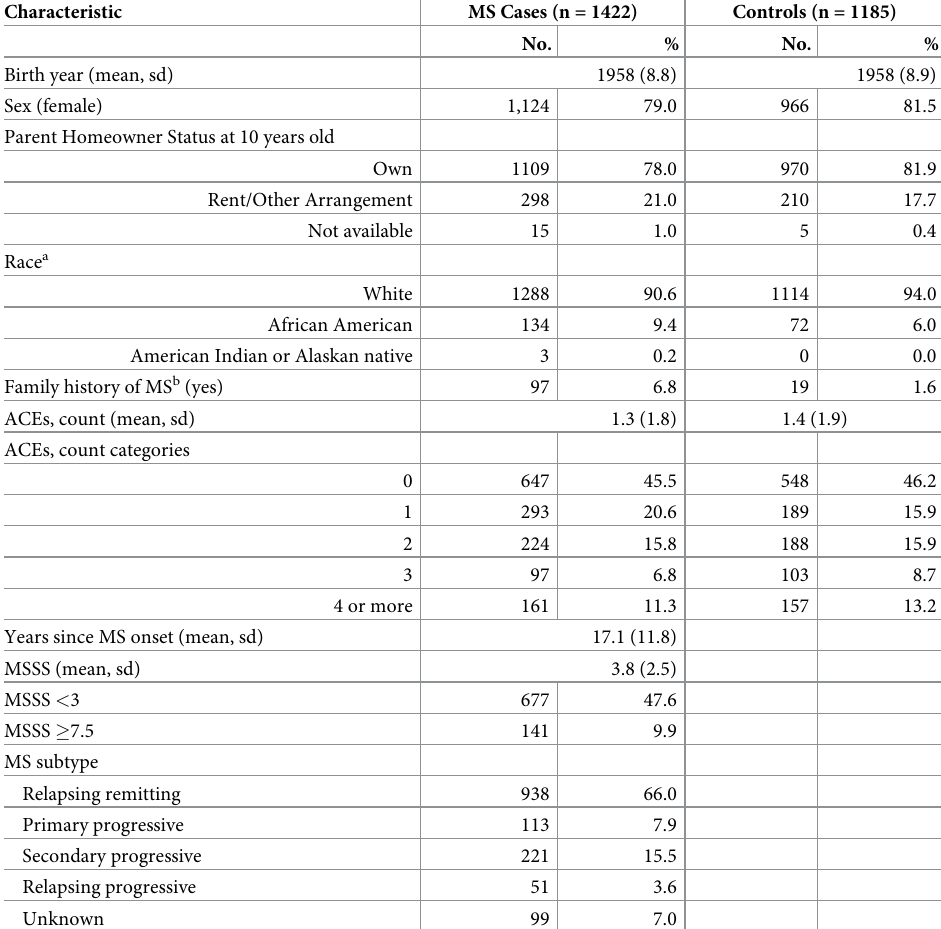
Table 2. Baseline characteristics among multiple sclerosis (MS) cases and controls in the Kaiser Permanente Northern California MS Research Program, 2006–2014 (n = 2607). Characteristic MS Cases (n = 1422)